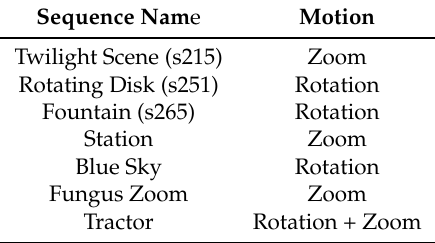
Table 1. Video Sequences.